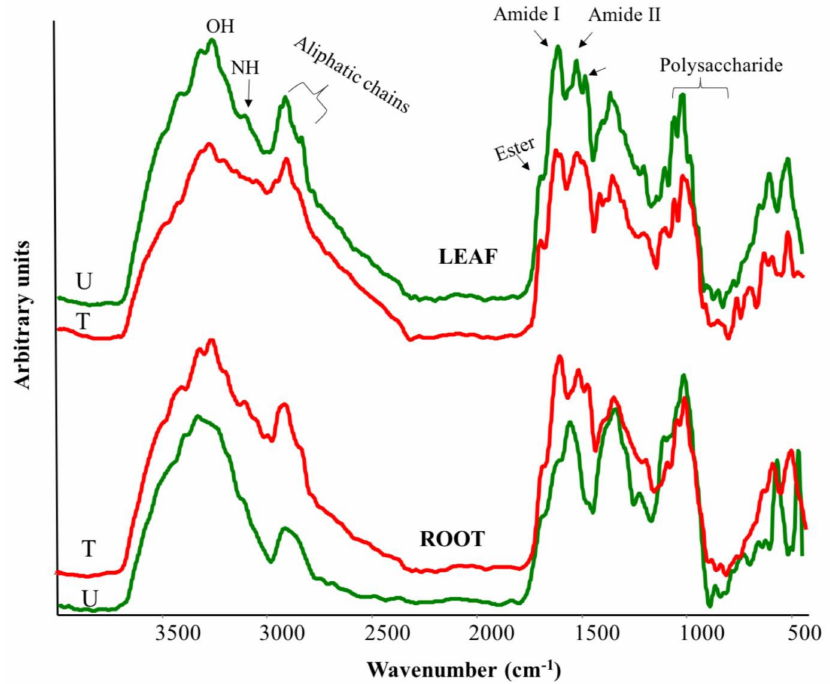
Figure 4. Fourier transform infrared (FTIR) spectra of leaves (top) and roots (bottom) from plant maize untreated and treated with high dosage (=4.2 mg/kg N) of